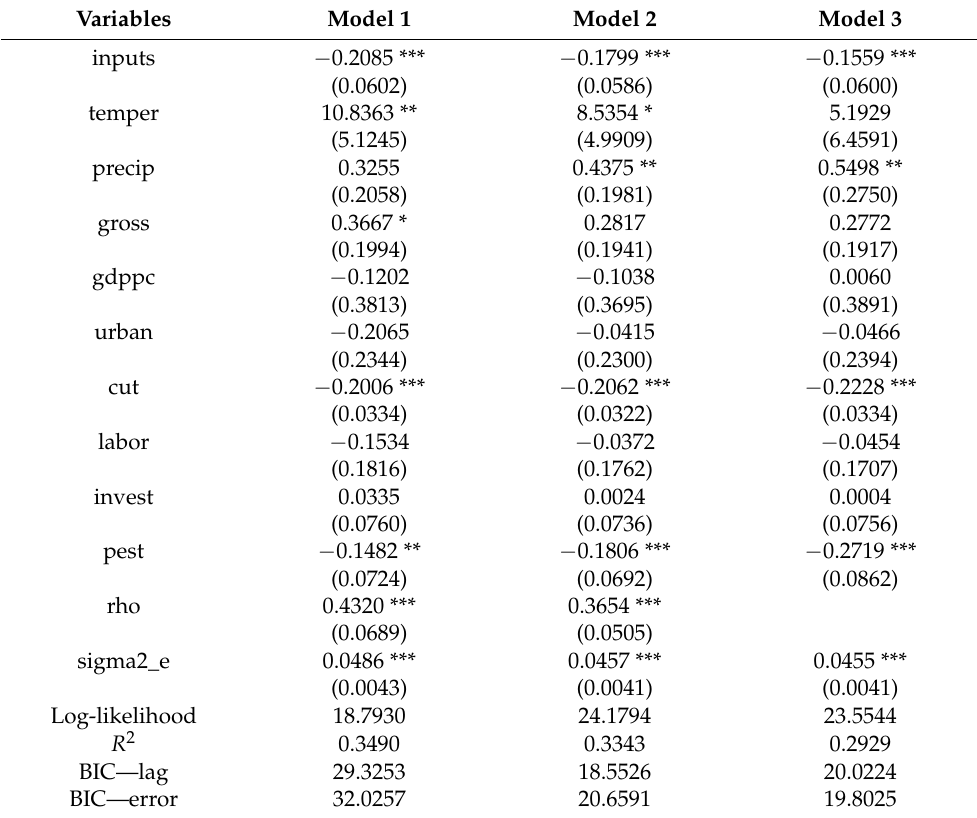
Table 3. Forest carbon sequestration efficiency influencing fitting